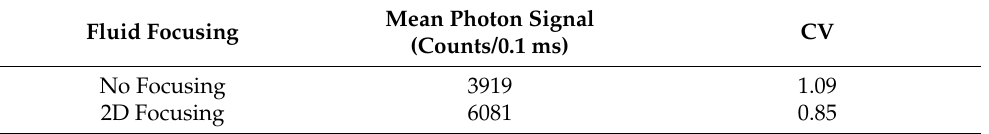
Table 4. Mean and CV for a biosensor illuminated by a four-micron-wide spot laser. Fluid Focusing